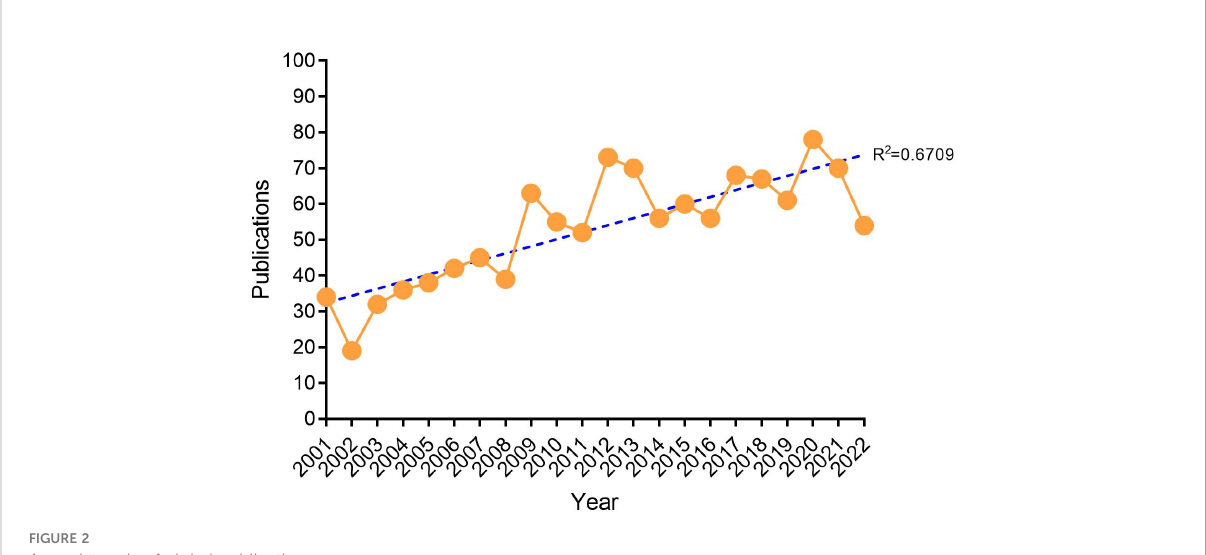
FIGURE 2 Annual trends of global publications.